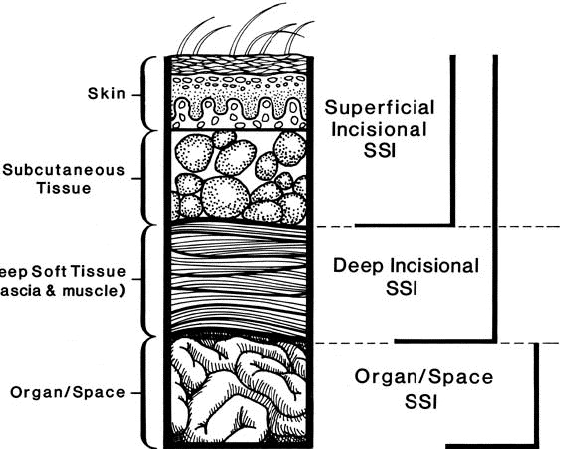
Figure 2. Types of surgical site infection (SSI) according to the type of tissue involved [12] . Reprinted with permission from ref [12] . © 1992 Elsevier.